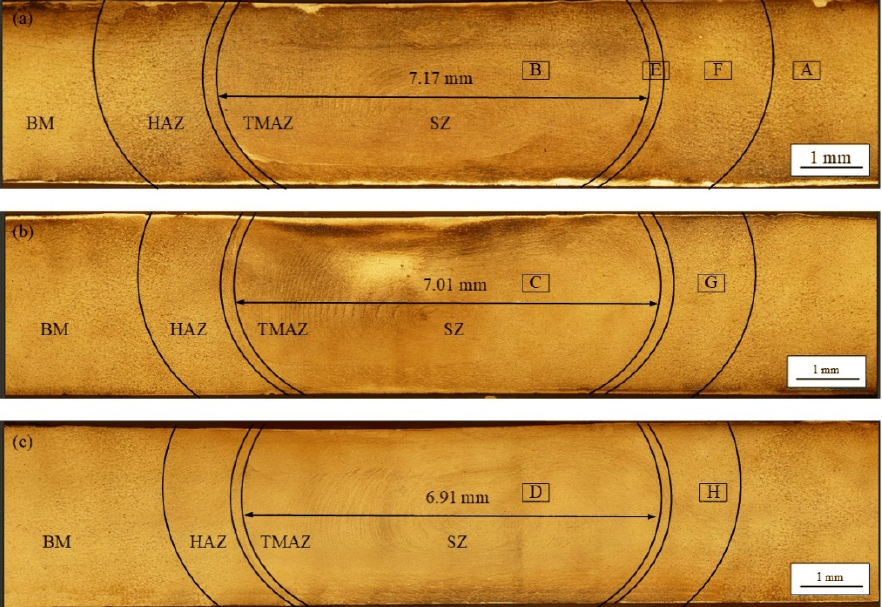
Figure 6. Cross sections with the RE sleeve under different welding speeds: ( a ) 110 mm/min, ( b ) 150 mm/min and ( c ) 190 mm/min.